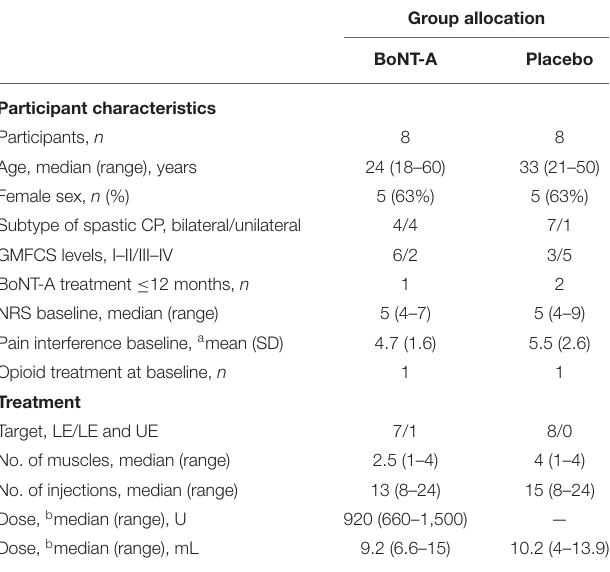
TABLE 2 | Participant characteristics and treatment